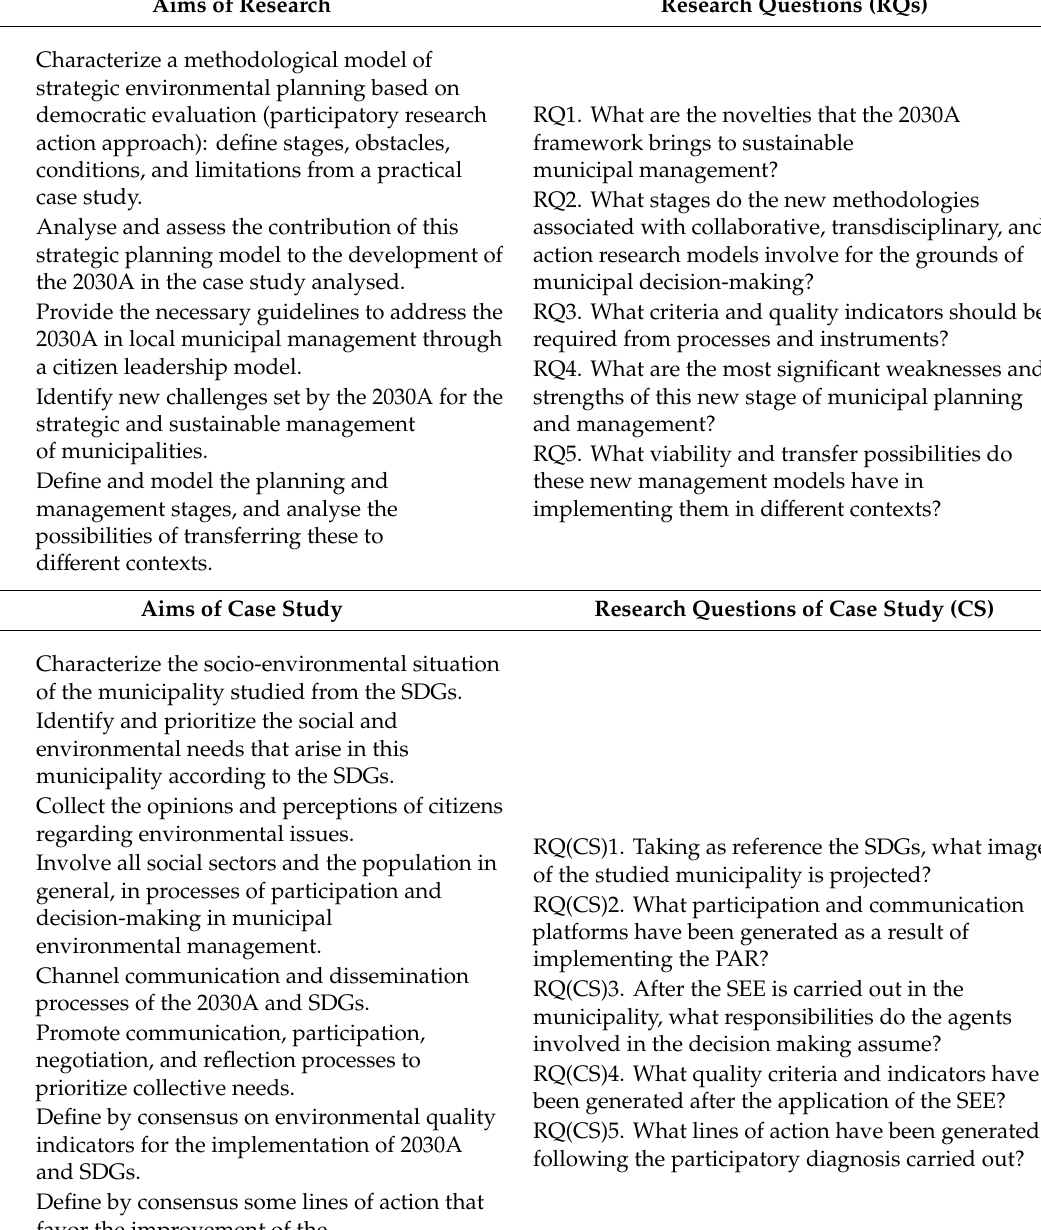
Table 1. Aims and research questions. SDGs, Sustainable Development Goals; PAR, participatory action research; SEE, strategic environmental